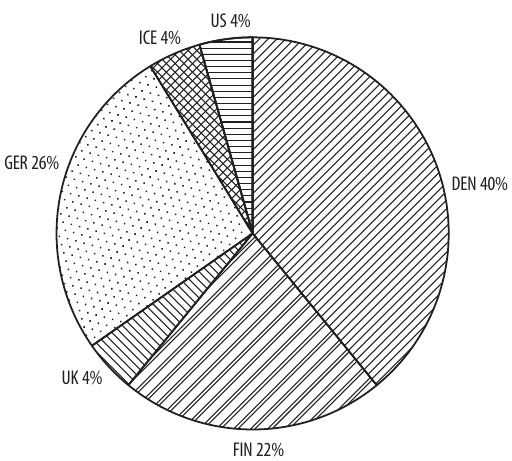
Figure 1. Respondents by their country of